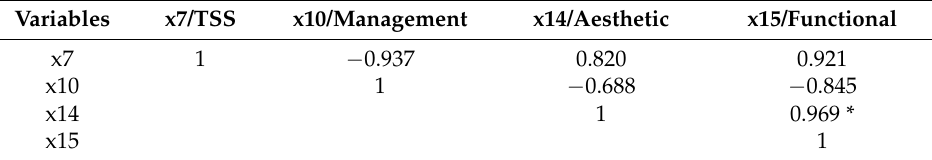
Table 8. CA for a second principal component of LCTIP by SPSS 22.0.